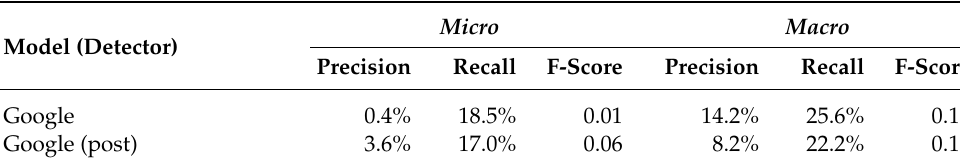
Table 7. Keyword detection performance on the final evaluation dataset (CC PL,real